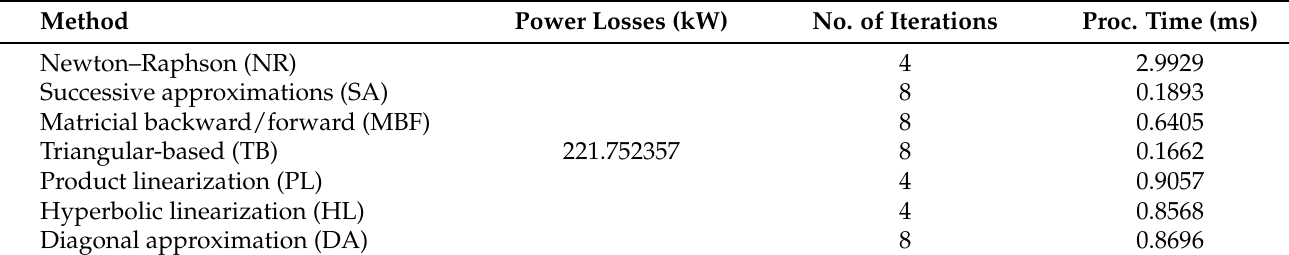
Table 4. Power flow performance in the IEEE 34-bus system.